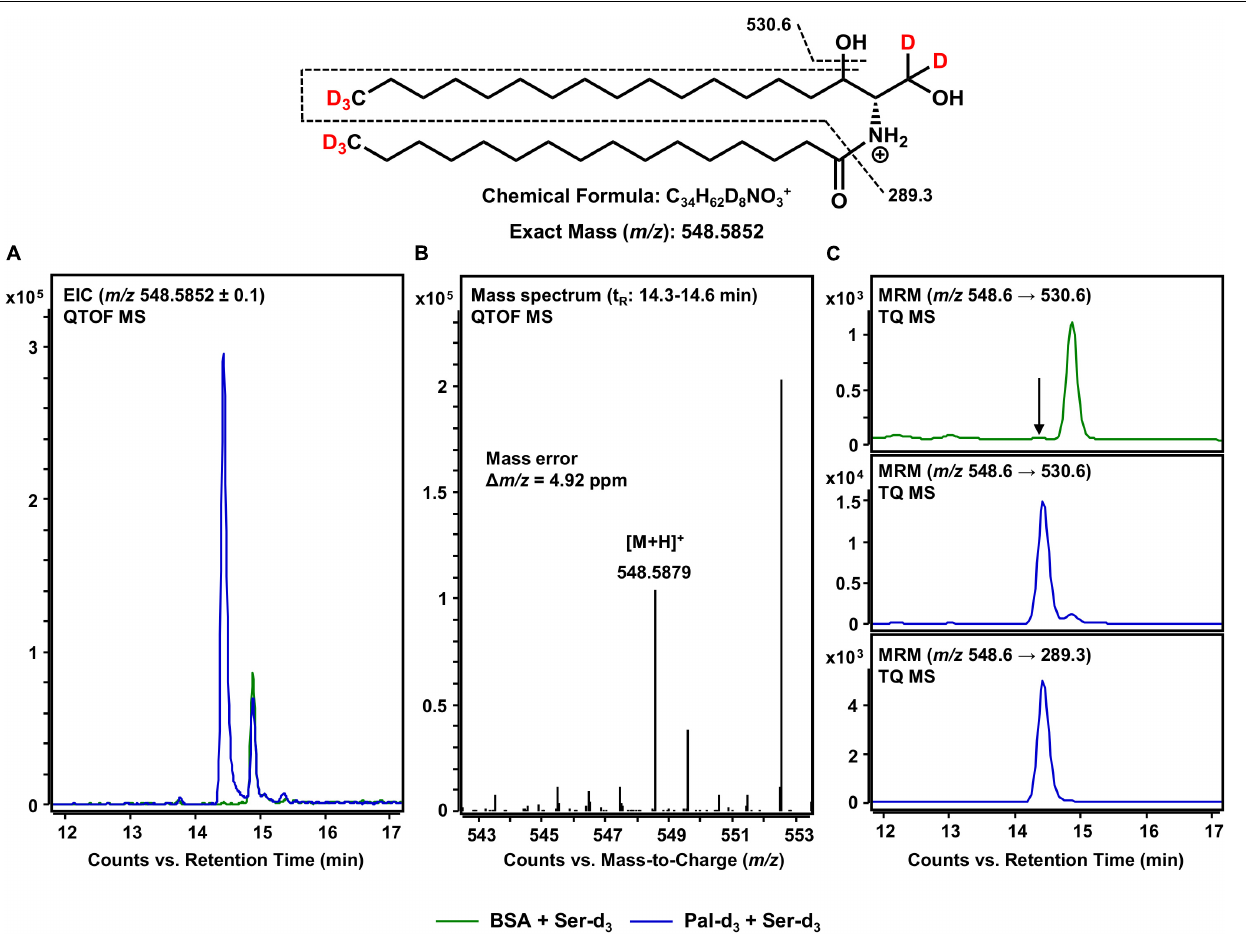
FIGURE 5 | Formation of Cer d18:0-d 5 /16:0-d 3 from de novo formed d18:0 Sph-d 5 and assay substrate palmitate-d 3 . (Top) Chemical structure, formula, and exact mass of the protonated molecular ion [M+H] + of Cer d18:0-d 5 /16:0-d 3 generated during electrospray ionization. Dashed black lines represent the mass transitions used for multiple reaction monitoring (MRM). (A) Overlay of extracted ion chromatograms (EIC) from the microsomal de novo synthesis assay using palmitate-d 3 and serine-d 3 as substrates (blue), compared to the negative control omitting palmitate-d 3 (green). (B) Mass spectrum extracted from the EIC in the retention time window of eluting Cer d18:0-d 5 /16:0-d 3 with annotation of the molecular ion peak and the calculated mass error. (A,B) Analysis was conducted on a quadrupole time-of-flight mass spectrometer (QTOF MS). (C) MRM analyses of assay (blue) compared to negative control sample (green) performed with a triple quadrupole mass spectrometer (TQ MS). For the negative control, only the mass transition with highest intensity ( m/z 548.6 → 530.6) is shown. The arrow indicates the retention time (t R ) of Cer d18:0-d 5 /16:0-d 3 . (A) At t R = 15 min, a relatively abundant unidentified compound ( m/z : 548.4852 ≤ x ≤ 548.6852) eluted that was present in both assay and negative control samples. (C) Analysis of two analyte-specific fragmentations allowed for unambiguous discrimination between Cer d18:0-d 5 /16:0-d 3 and matrix